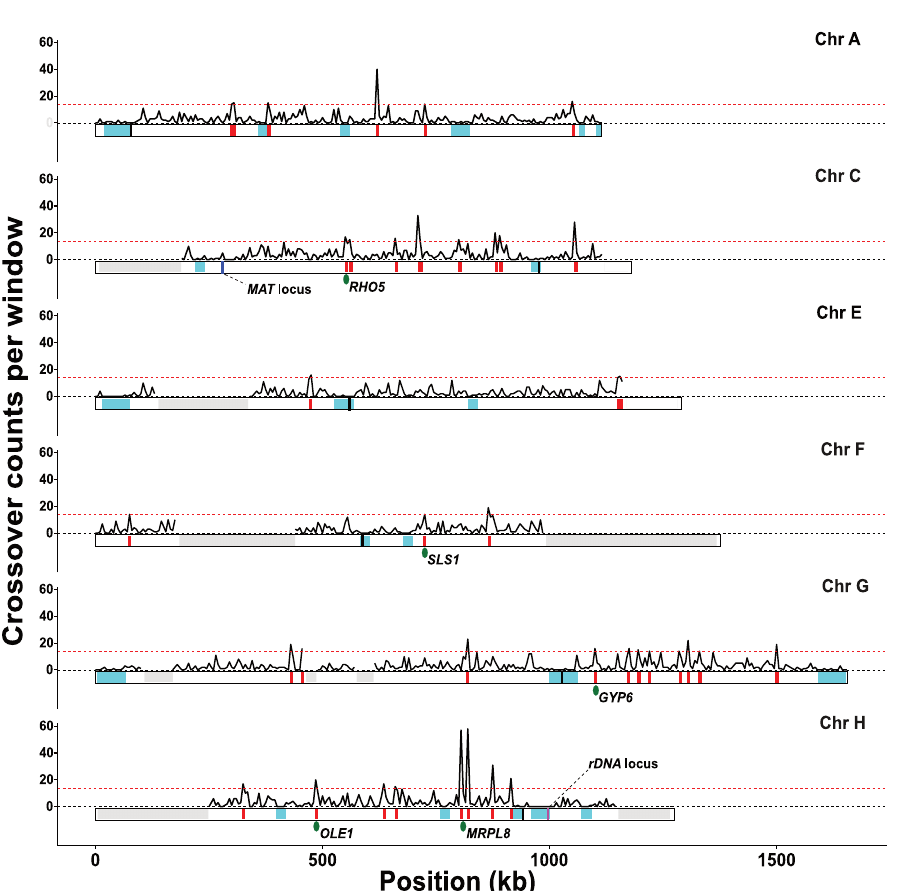
Fig 1. L . waltii recombination map. Density of crossovers along the genome using a 5 kb window. Grey shaded areas represent LOH regions from the parental hybrid. Horizontal dashed red line represents crossover hotspot significance threshold (see Materials and methods). Under the density plot, crossover coldspots and hotspots are shown in cyan and red, respectively. For each chromosome a black dash represents centromere position. Blue and purple dashes represent MAT locus on chromosome C and rDNA locus on chromosome H respectively. S . cerevisiae conserved hotspot positions are represented by green ovals [53,61].Note that two COs frequently took place in the same meiosis in the two hotspots near MRPL8 and involved only two chromatids most of the